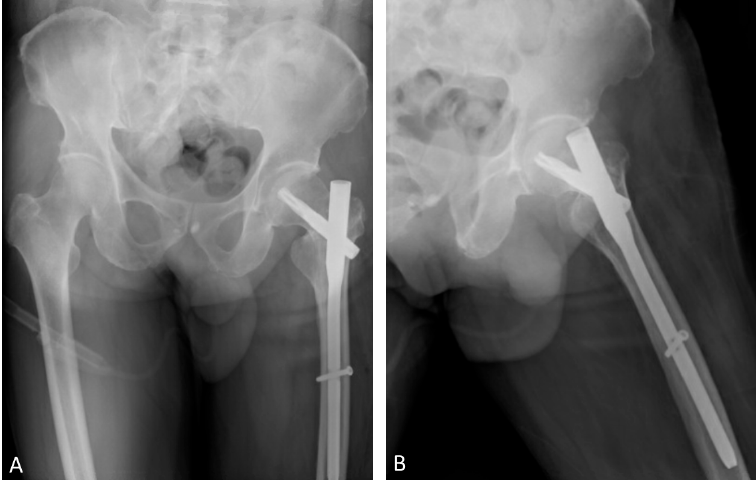
Figure 2. ( A , B ) Orthogonal views of postoperative radiographs, showing varus alignment and neck